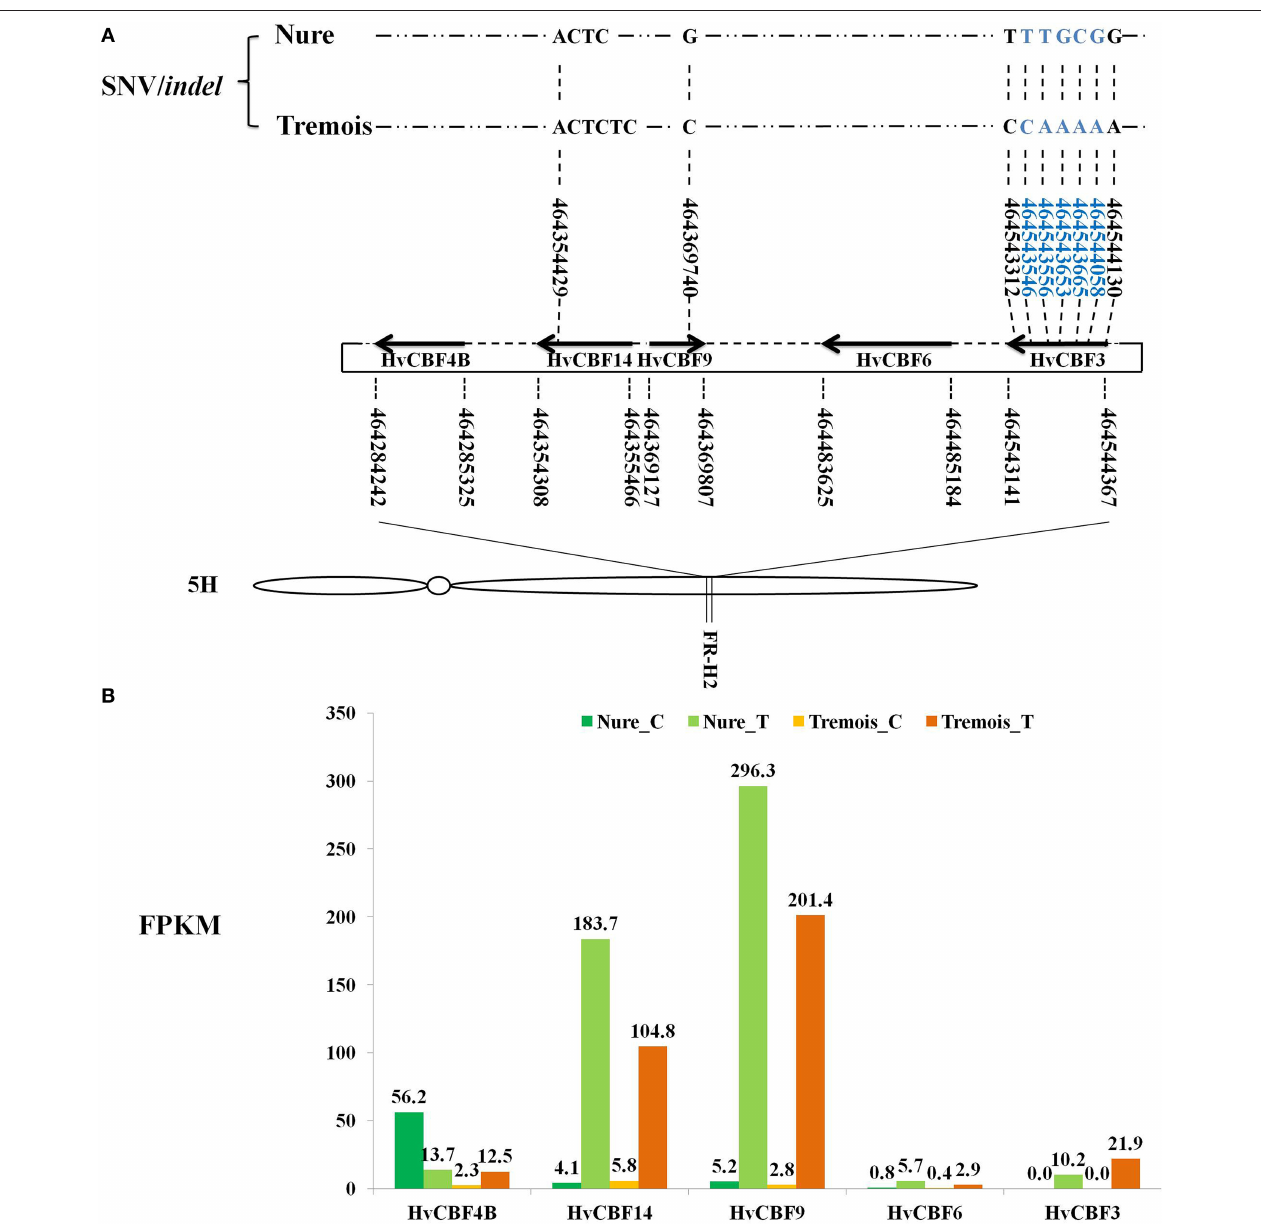
FIGURE 4 | Feature of HvCBFs in FR-H2 locus of Chromosome 5H in barley. (A) Distribution and SNV/ indel characteristics of HvCBFs in FR-H2 locus. Boundaries of HvCBFs in FR-H2 locus are illustrated by bold arrows. The numbers under and above gene names are physical locations of genes and SNV/ indel , respectively. Right and left arrows show positive and negative strand of HvCBFs on the assembly genome. SNVs/ indels sequence differed between Nure and Tremois are shown, and SNVs/ indels in blue locate in the coding domain sequence (CDS) regionof HvCBF3 . Indel , insertion or deletion variant. SNV, single nucleotide variant. Distributions of HvCBFs in FR-H2 locus refer to Pasquariello et al. (2014). (B) Expression values of HvCBFs in FR-H2 locus. Fragments per kilo base per million map reads (FPKMs) of samples are labeled above each bar. Nure_C, Nure in control. Nure_T, Nure in treatment. Tremois_C, Tremois in control. Tremois_T, Tremois in